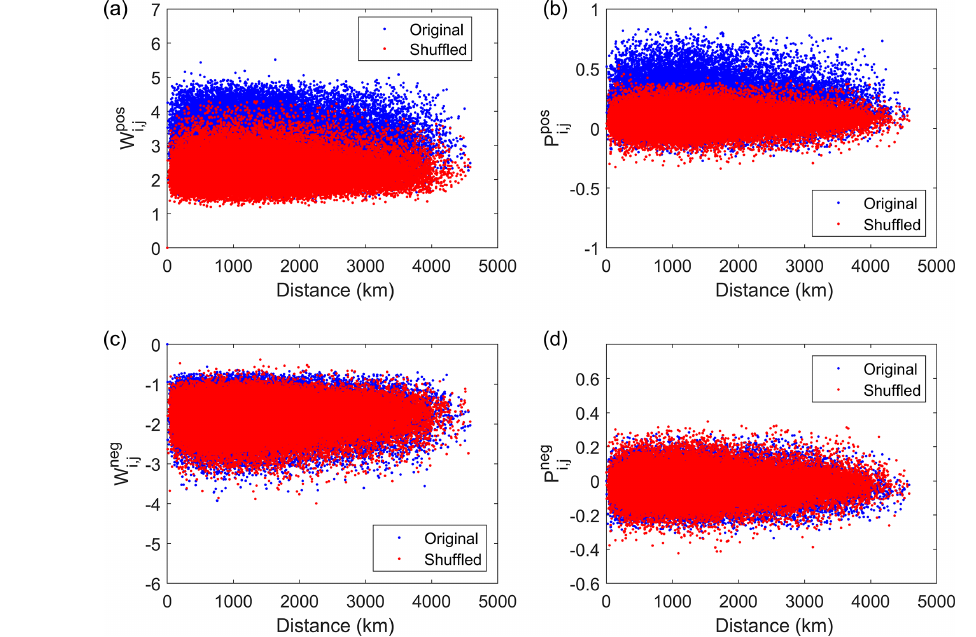
pos and (b) P pos for real (blue) and shuffled (red) data. i,j i,j